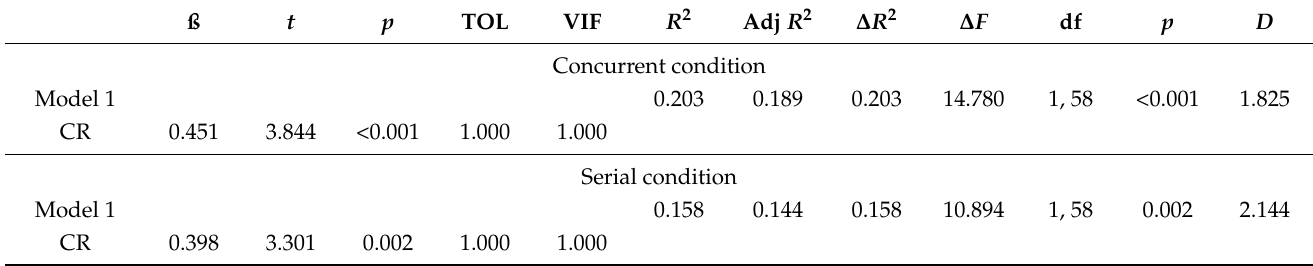
Figure 4. Decomposition of the variance in noncanonical sentences (NoCS) explained jointly and uniquely by cognitive reserve (CR), measured by the cognitive reserve questionnaire (CRQ); working memory (WM), measured by the digit ordering task (DO); and the rest of the measures (RMs: age, MMSE, GDS-15, and MFE).